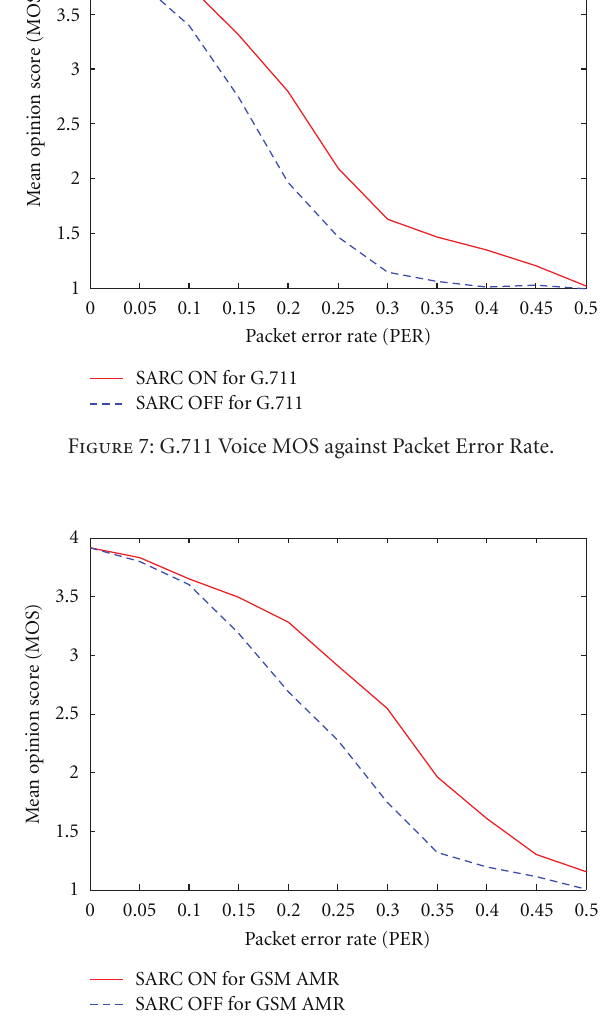
Figure 8: GSM AMR MOS against Packet Error Rate.